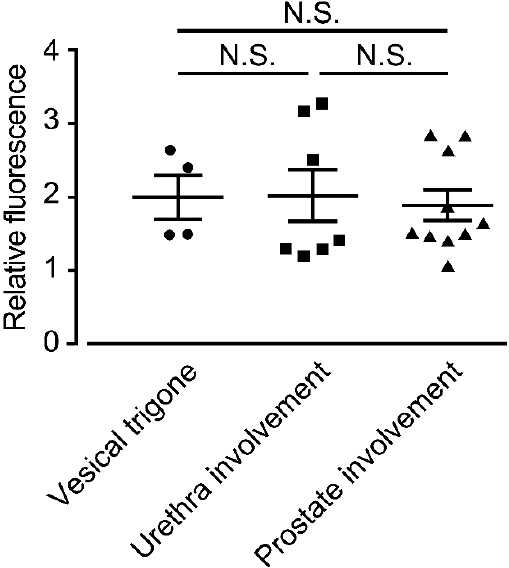
Figure A3. Fluorescence intensity in vesical trigone ( n = 4), urethra involvement ( n = 7) and prostate involvement ( n = 10). Fluorescence intensity is expressed as a ratio of the amount of fluorescence in the 5-ALA supplemented group relative to the amount of fluorescence in the vehicle group for each sample. The horizonal lines indicate the mean ± SD.